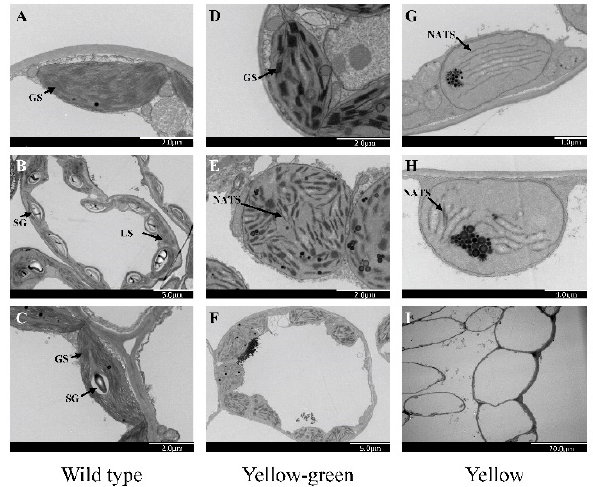
Figure 7. Transmission electron microscopy of the chloroplast ultrastructure, ( A – C ) Electron micrographs showing mesophyll cells and ultrastructure of chloroplast in wild type, ( D – F ) yellow-green leaf mutants, ( G – I ) yellow leaf mutants. GS, granal stack; SG, starch grain; NATS, non-appressed thylakoid stacking; LS, lamellar structure.